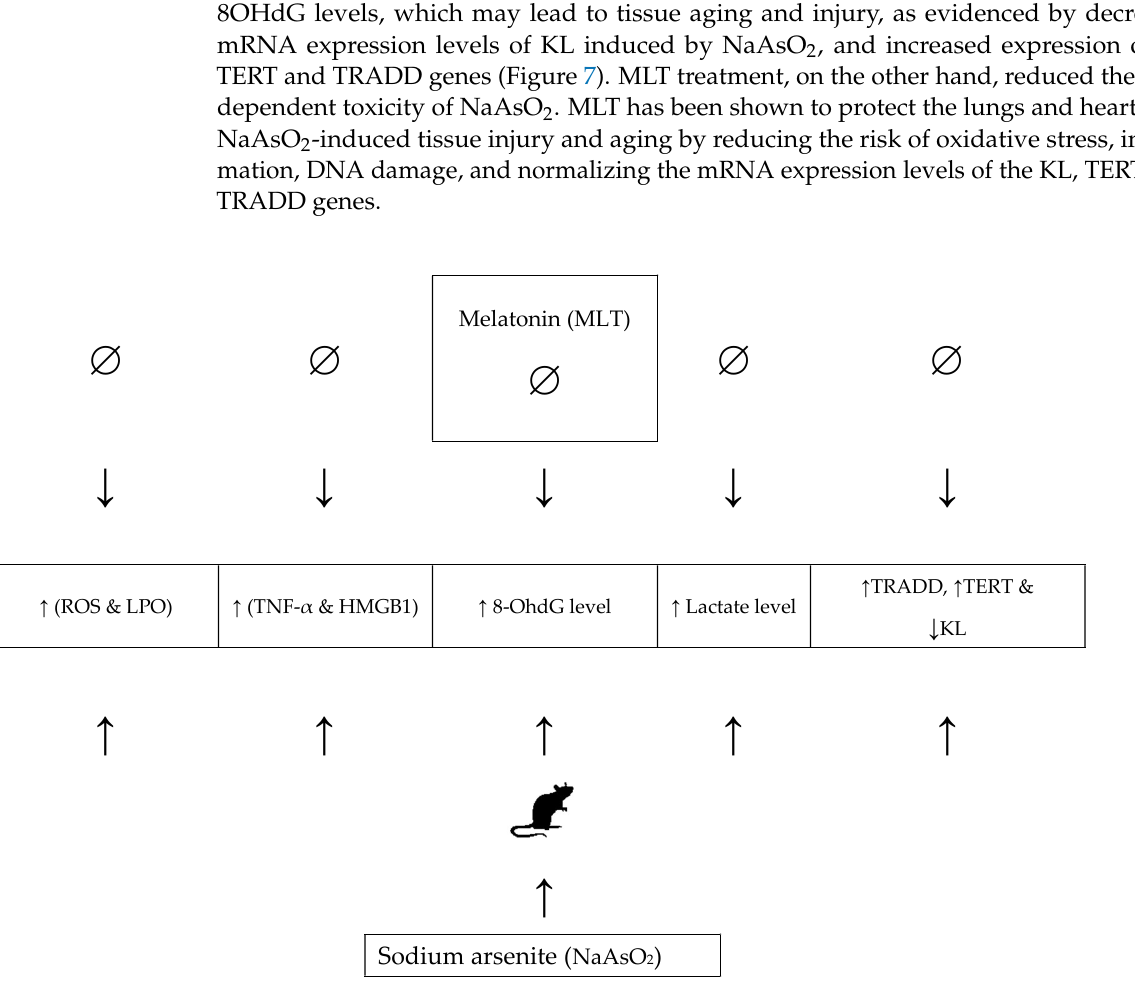
Figure 7. The role and mechanism of melatonin in alleviating NaAsO2-induced aging. Abbreviations: ROS: reactive oxygen species; LPO: lipid peroxidation; HMGB1: high mobility group box 1; TRADD: Tumour necrosis factor- α (TNF- α ) receptor type 1-associated death domain; TERT: telomerase reverse transcriptase; KL: Klotho.